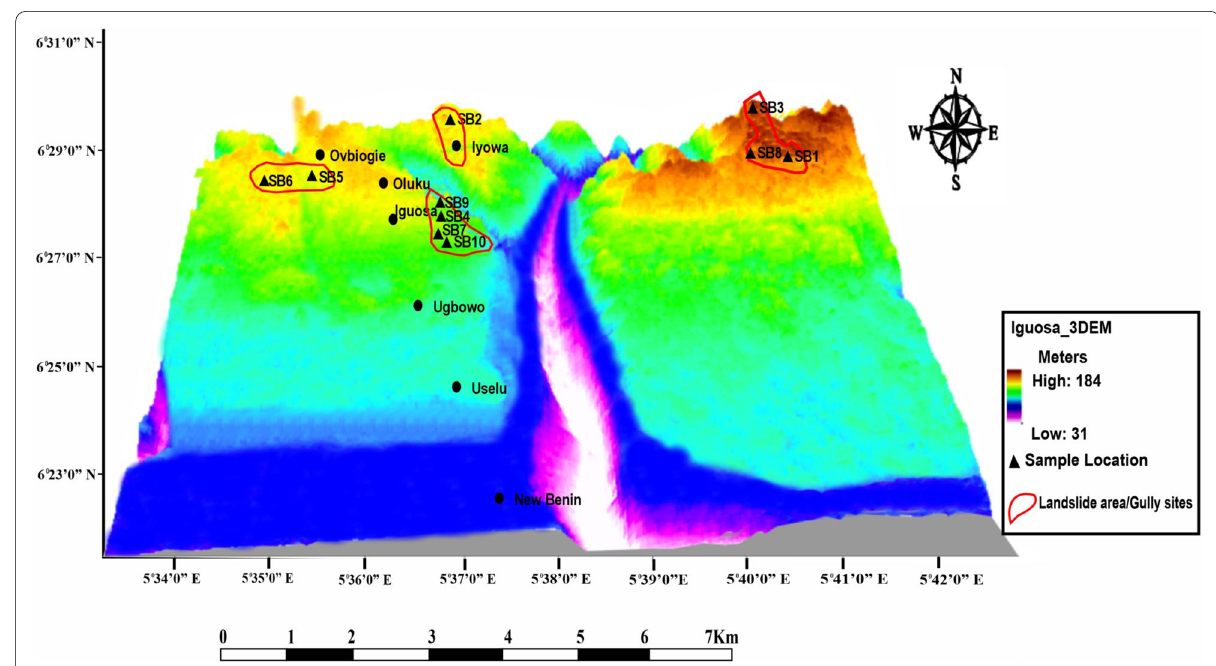
Fig. 2 Digital elevation map of Iguosa and surrounding environs showing landslides prone areas generated from NASA SRTM-30